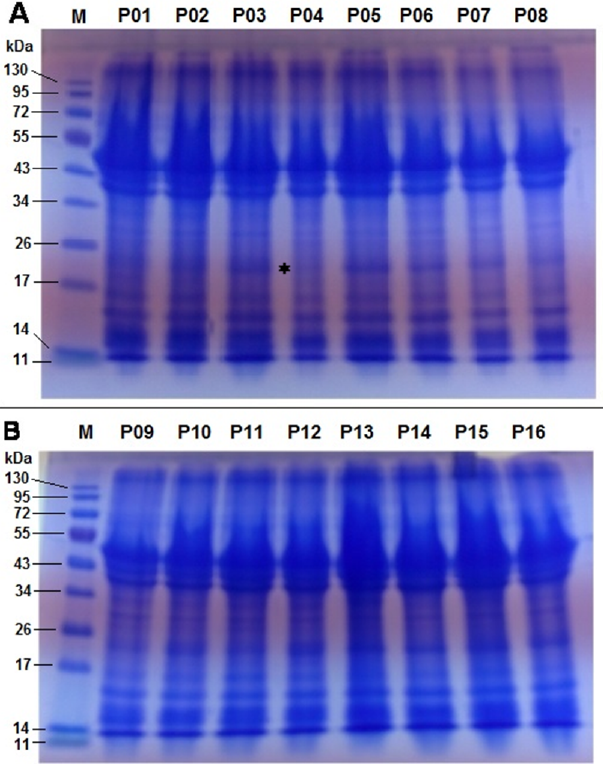
Figure 5. UPGMA dendrogram based on Jaccard’s similarity of seed total protein profiles showing close relationship among Parkia biglobosa